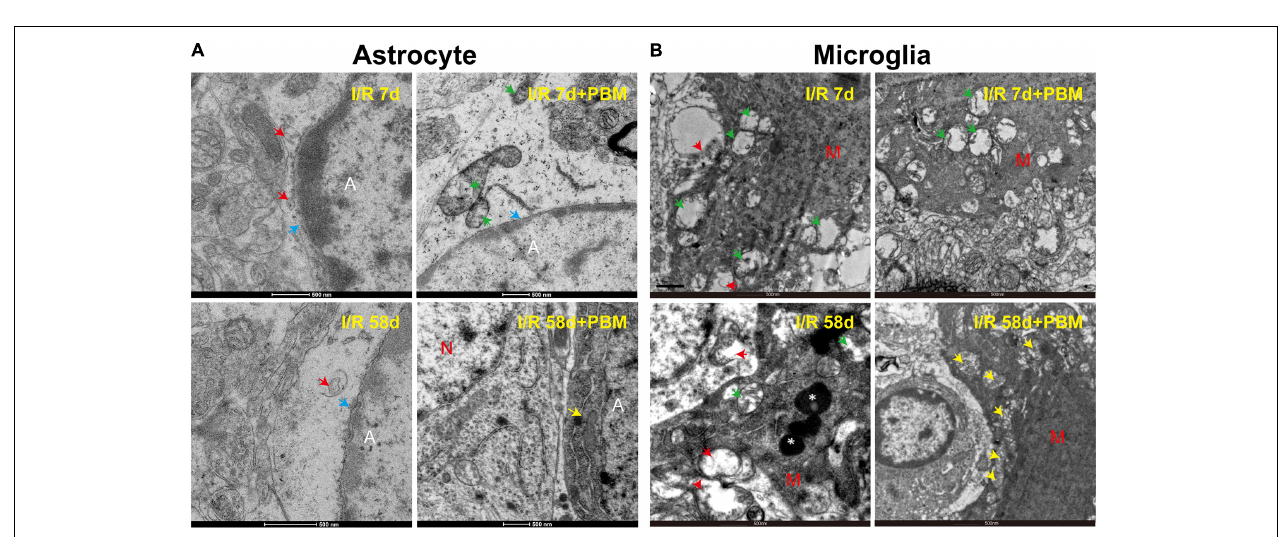
FIGURE 6 | Photobiomodulation treatment inhibits GCI-induced expression of NLRP3 and activates IL-1 β in the hippocampal CA1 region following GCI. (A) Representative images of double IF staining of GFAP/NLRP3 and Cle-IL-1 β /GFAP in the indicated groups. Fluorescence intensity quantification of NLRP3 (a1) or Cle-IL-1 β (a2) . Data are expressed by the ratio of fluorescence intensity of the section compared to sham. Colocalization between the two stained proteins for GFAP/NLRP3 (a3) and Cle-IL-1 β /GFAP (a4) . (B) Representative images of IF staining for Iba1 (a microglial marker) and fluorescence intensity quantification (b) ( n = 5–6 in each group). ∗∗ P < 0.01; ∗∗∗ P < 0.001; scale bar 50 µ m; magnification 40 × .